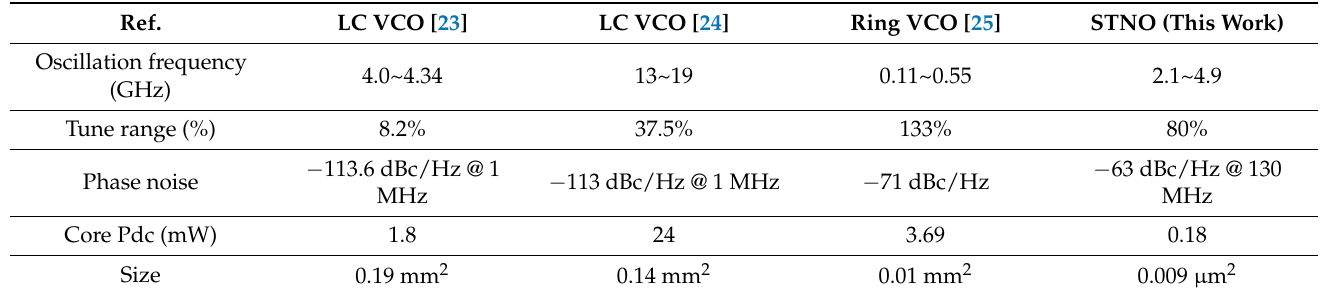
Table 2. The STNO Performance comparison with other